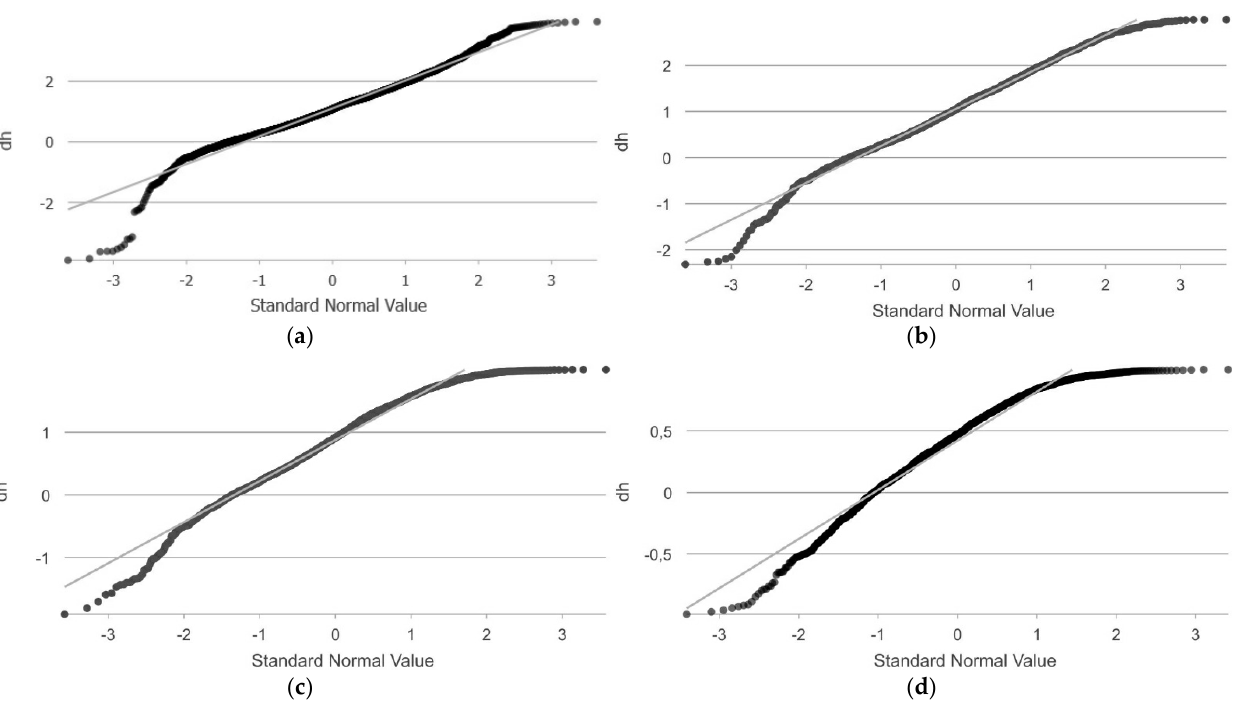
Figure 6. Quantile–quantile plots showing distributions of: ( a ) |dh| < 4 m; ( b ) |dh| < 3 m; ( c ) |dh| < 2 m; ( d ) |dh| < 1 m. The light grey line indicates the reference of the QQ plot.